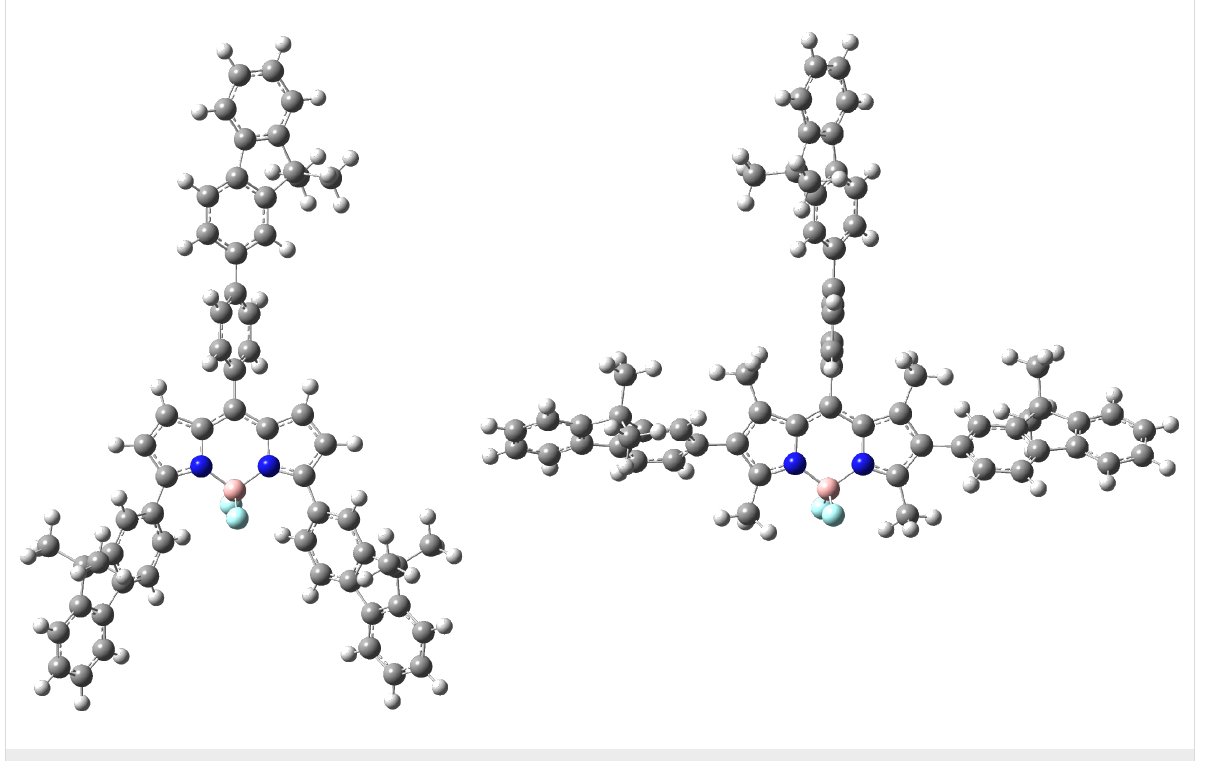
Figure 4: Optimised structures of T-B1 (left) and Y-B1 (right).